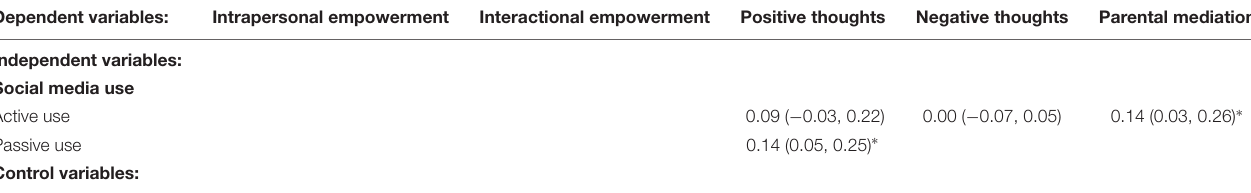
TABLE 5 | Indirect effects of media use on parental views and mediation.